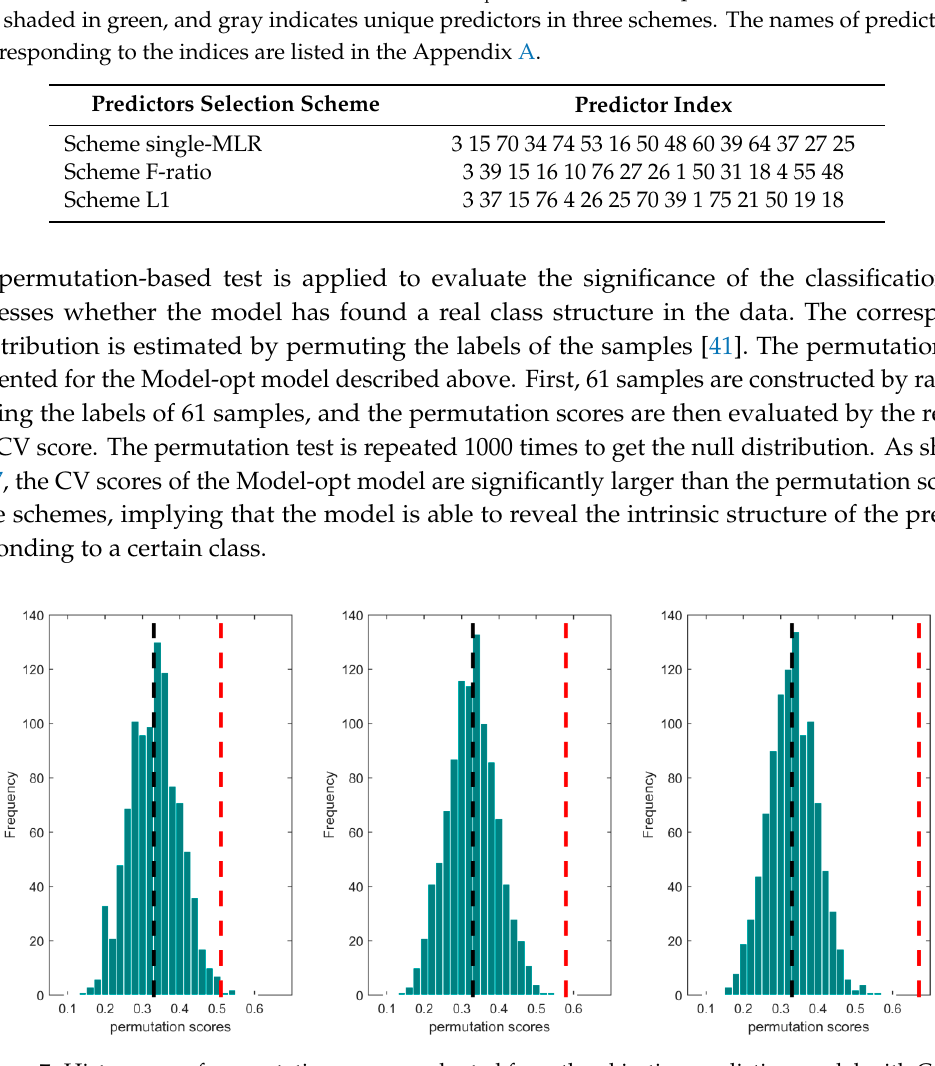
Figure 7. Histograms of permutation scores evaluated from the objective prediction model with C thrd of 0.8 and N pre of 15 by 1000 times for the schemes single-MLR ( left panel ), F-ratio ( middle panel ), and L1 ( right panel ), respectively. The red dashed line indicates the CV score of the Model-opt model.